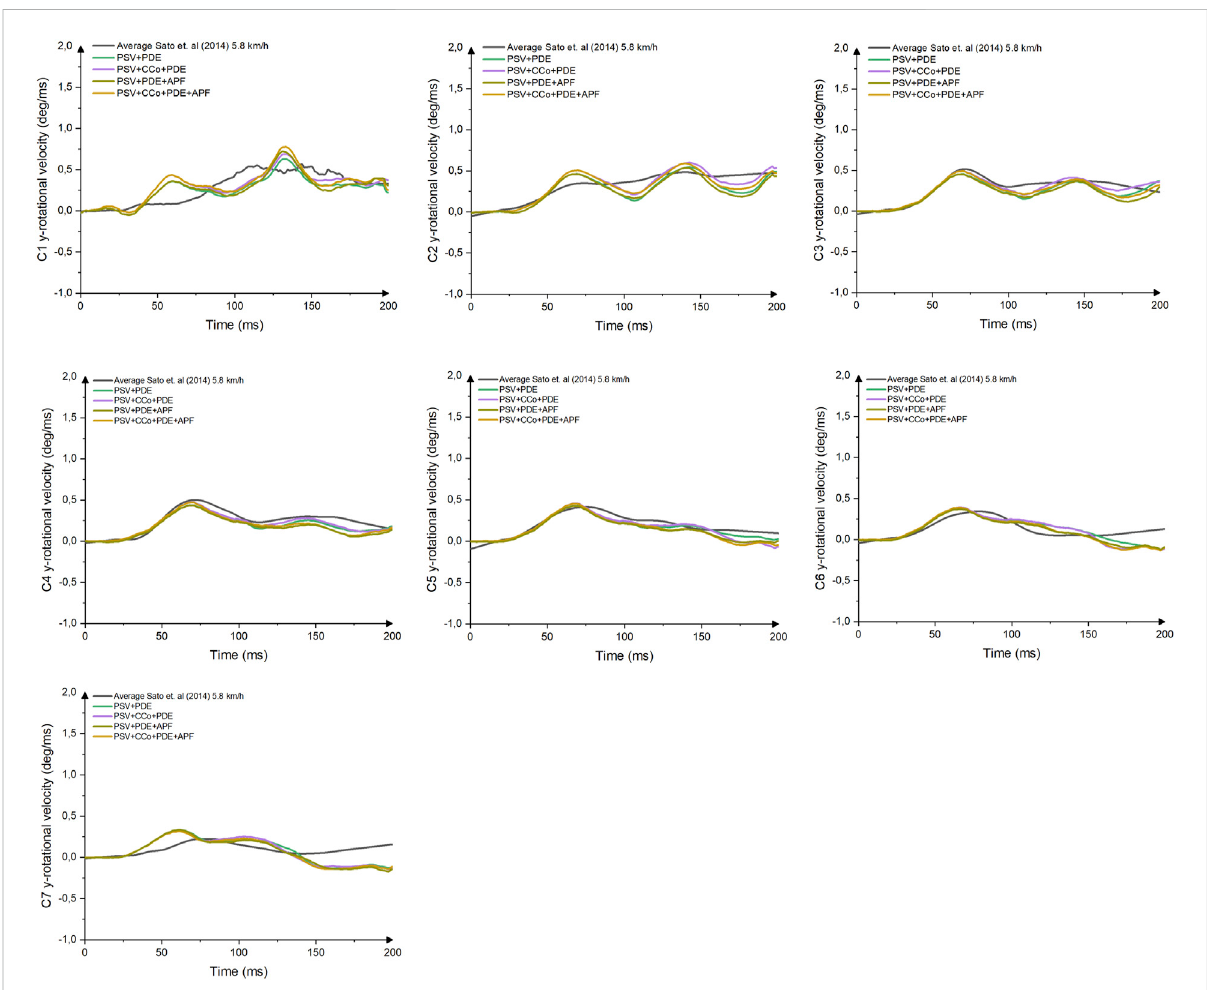
FIGURE 7 Comparison of Cervical Vertebral Rotational y-Velocity between Female Models with Various Complexities and Volunteer Kinematics.